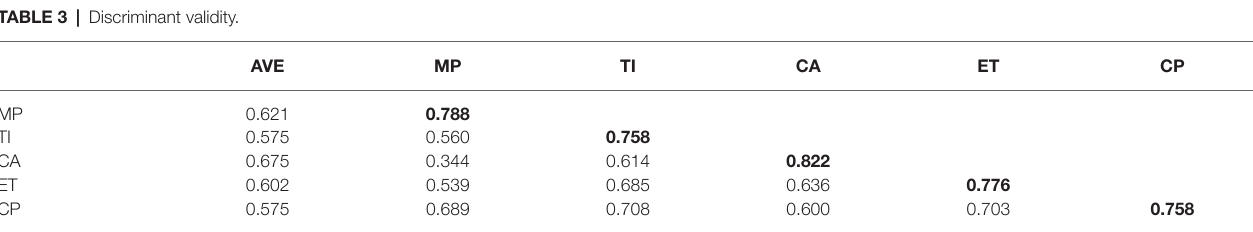
TABLE 3 | Discriminant